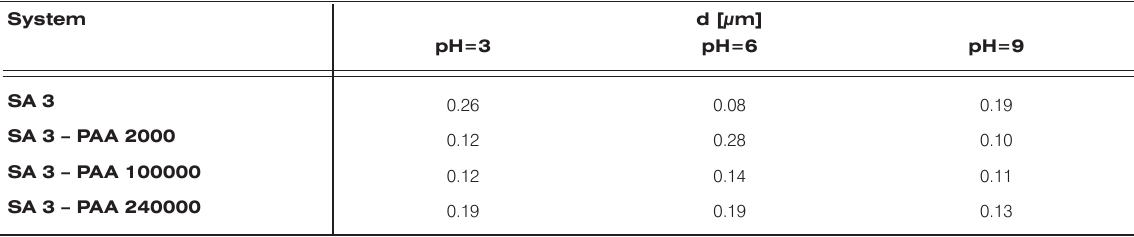
Table 2. The average size of aggregates (flocs) formed in SA 3 suspension in the absence and presence of polyacrylic acid. System